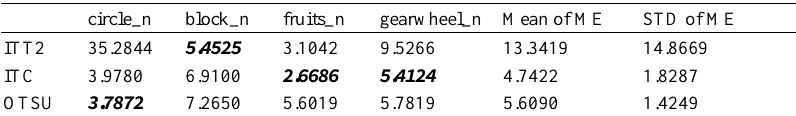
Table 7. Result of experiment